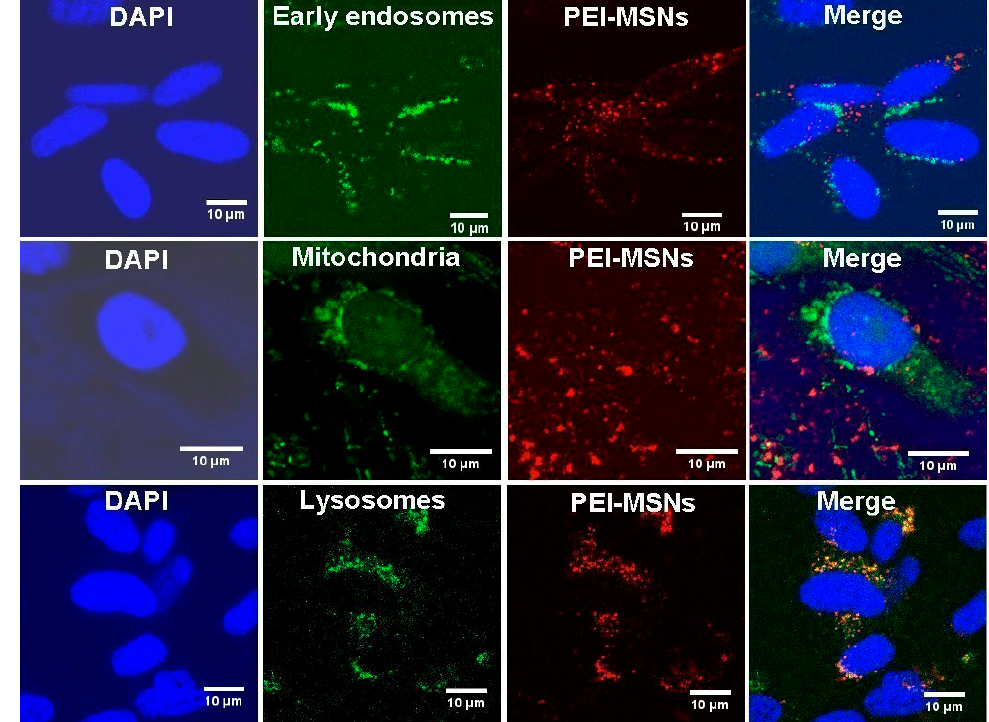
Figure 6. Localization of the PEI-MSNs in the treated BT-12 (cultured in stem cell conditions) GSCs by confocal microscopy. The intracellular localization of PEI-MSNs (red) was studied using markers of early endosomes, mitochondria, and lysosomes (green color). The nuclei were visualized by using DAPI (blue). The co-localization of the PEI-MSNs with lysosomes is seen in yellow.